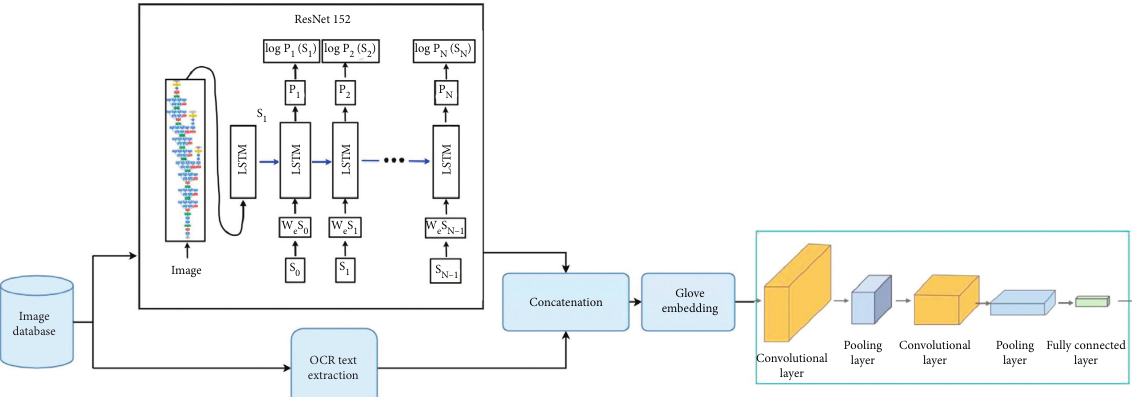
Figure 1: Working of sequential